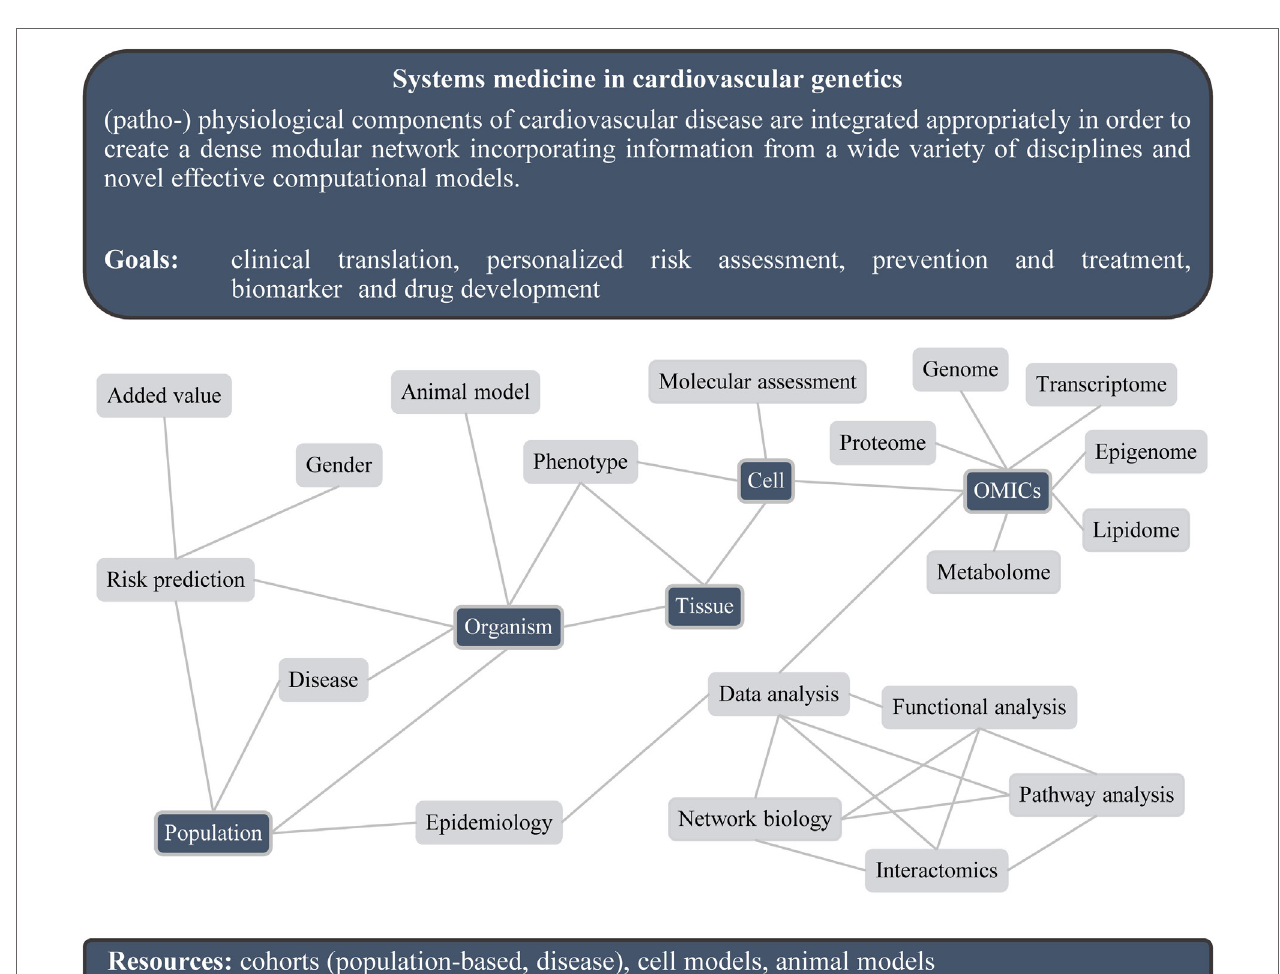
FiGURe 1 | Systems medicine approaches in cardiovascular genetics